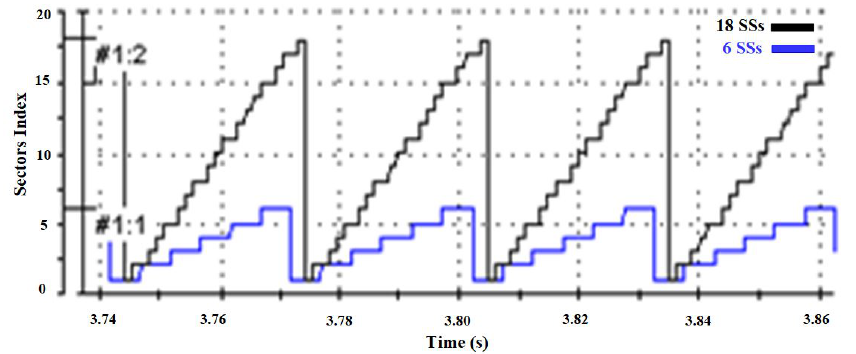
Figure 32. Sector index for the conventional 6 sectors and the proposed 18 SSs.